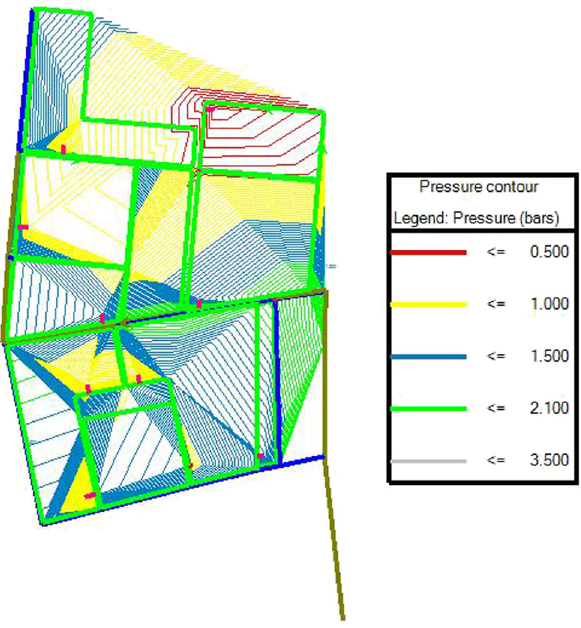
Figure 8: Contour map of pressure heads during maximum water demand.